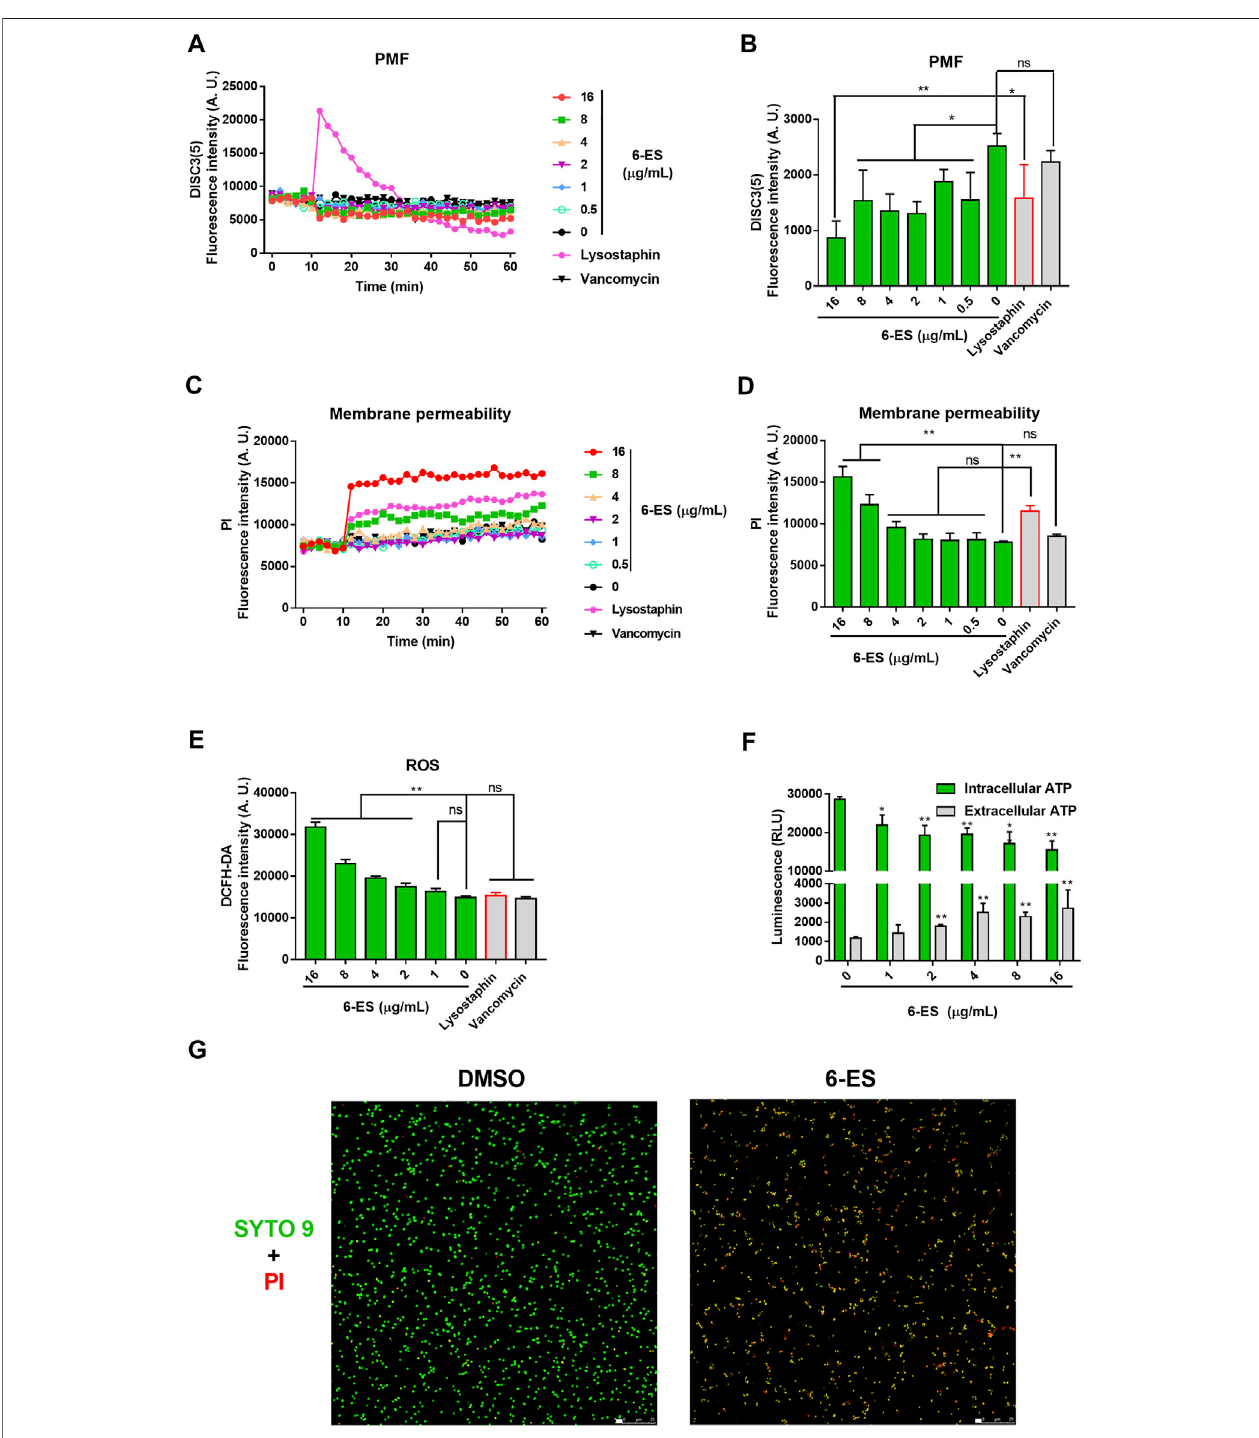
FIGURE2| 6-ESrapidlydisruptedmembranefunctionandpromotedthegenerationofROSin S.aureus. (A,C) MRSAT144cellswereincubatedwithDISC3(5)or PI for 10 min and then treated with 6-ES for 50 min. The dynamic fl uorescence intensities were measured every 2 min (B,D) DISC3 (5) or PI fl uorescence intensities of MRSA T144treated with 6-ES for30 min. Data are presented as themeans ±SDs. * p < 0.05, ** p < 0.01. (E) MRSA T144cells were incubated with DCFH-DA, followed by treatment with 6-ES for 30 min. The fl uorescence intensities were measured at excitation/emission 488/525 nm. Data are presented as the means ± SDs. * p < 0.05, ** p < 0.01. (F) MRSA T144cells were incubated with6-ES for30 min, and the levels ofextracellular ATPand intracellular ATPwere measured.Data arepresented as the means ± SDs. * p < 0.05, ** p < 0.01. (G) MRSA T144 cells were incubated with 6-ES (16 μ g/ml) or DMSO for 30 min and then stained with PI (red) and SYTO 9